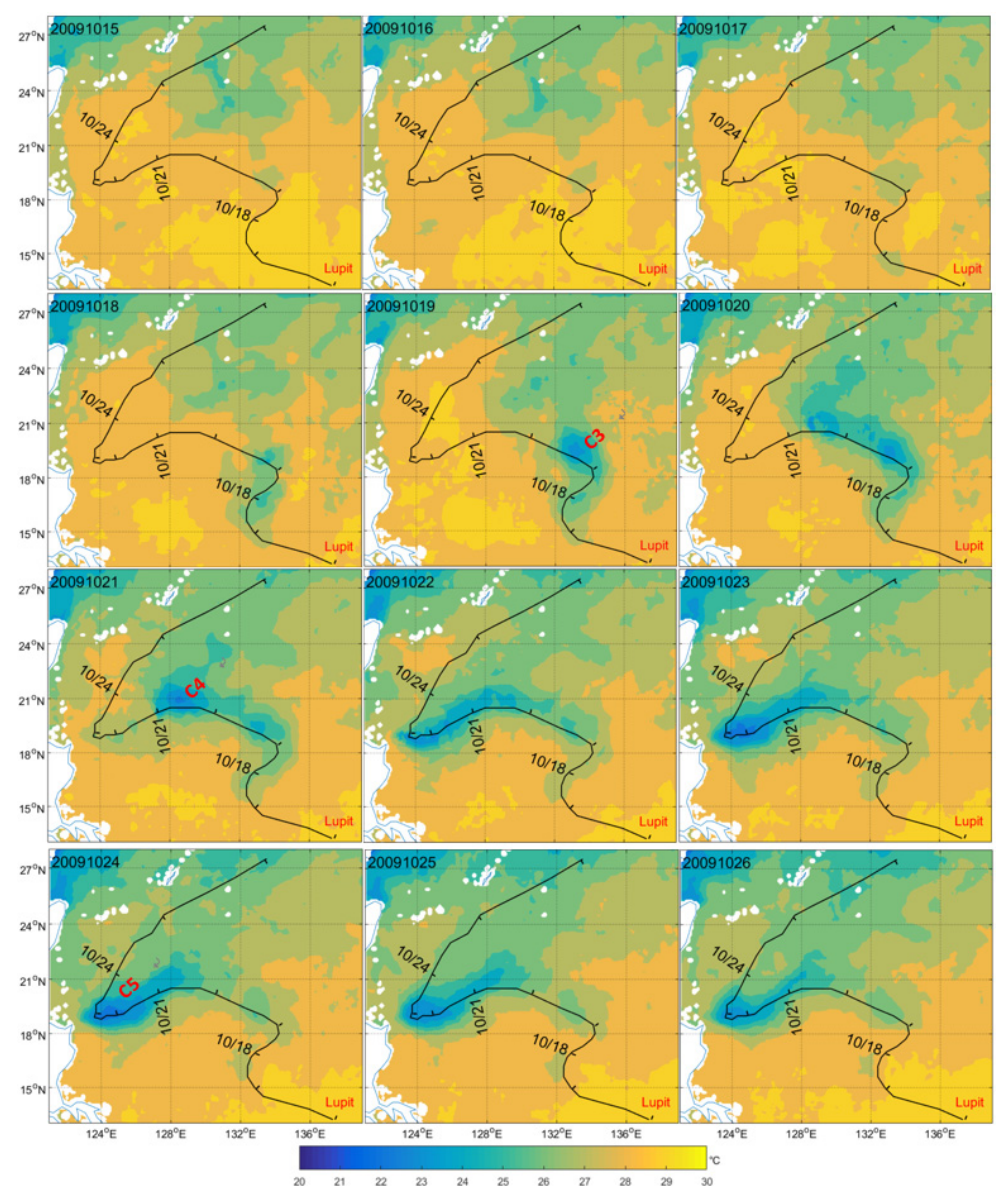
Figure 1. Sequence of daily SST images during the passage of Typhoon Lupit (15–26 October 2009). The color bar represents the temperature in °C and the black line shows the track of Typhoon Lupit.